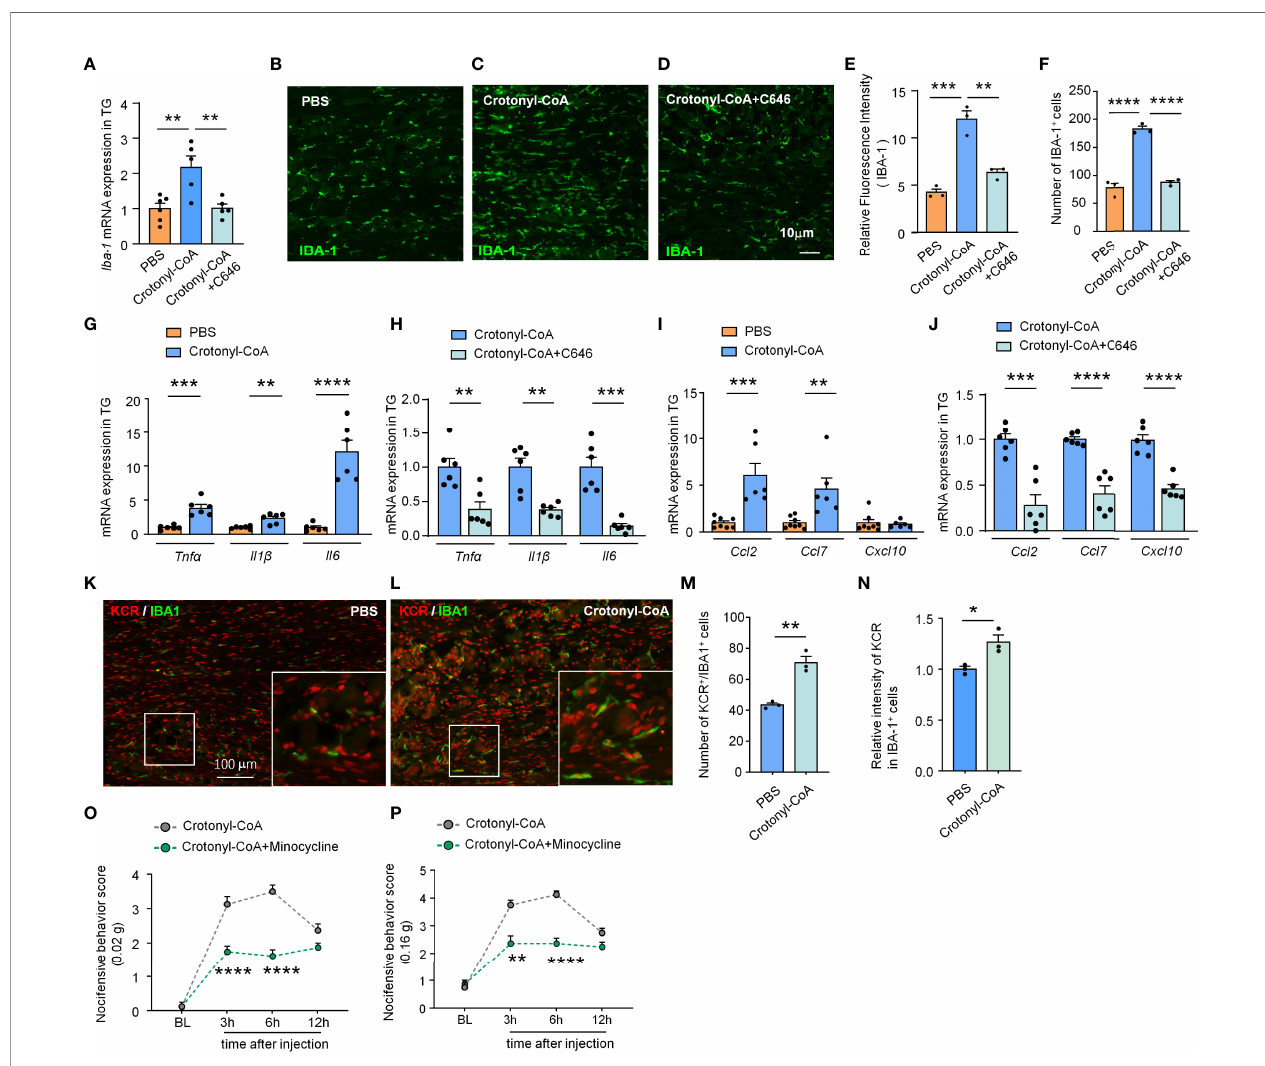
FIGURE 5 | C646 blocked crotonyl-CoA induced macrophage activation and the upregulation of in fl ammatory factors and chemokine in TG. (A) C646 suppressed the upregulation of Iba1 mRNA induced by Crotonyl-CoA Lithium in TG. ** P <0.01, n = 5-6, One-way ANOVA followed by Bonferroni ’ s test. (B – F) Representative images and Quantitative analysis of immuno fl uorescence staining showing C646 (1 m g) signi fi cantly decreased Crotonyl-CoA Lithium induced IBA-1 upregulation (E) and the number of IBA-1 positive cells (F) in TG. ** P <0.01, *** P <0.001, **** P <0.001, One-way ANOVA followed by Bonferroni ’ s test, n = 3 mice per group, 3 sections per mouse. (G) The mRNA levels of Tnf a , Il1 b and Il6 increased signi fi cantly after Crotonyl-CoA Lithium treatment, ** P <0.01, *** P <0.001, **** P <0.001, n = 6, student ’ s t-test. (H) C646 signi fi cantly decreased the mRNA expression of Tnf a , Il1 b and Il6 upregulated by Crotonyl-CoA Lithium, ** P <0.01, *** P <0.001, compared with the Crotonyl-CoA Lithium group, n = 6, student ’ s t-test. (I) Crotonyl-CoA Lithium signi fi cantly increased the mRNA level of Ccl2 and Ccl7 , ** P <0.01, *** P <0.001, compared with the PBS group, n = 6-8, student ’ s t-test. (J) C646 signi fi cantly decreased the mRNA expression of Ccl2 , Ccl7 and Cxcl10 , *** P <0.001, **** P <0.0001, compared to Crotonyl-CoA Lithium, n = 6, student ’ s t-test. (K – N) Representative images (K, L) and statistics of the number of KCR and IBA-1 double-positive cells (M) and the fl uorescence intensity of KCR in IBA-1 positive cells (N) 6 hours after intra-TG injection of PBS or Crotonyl-CoA Lithium on naïve mice. * P <0.05, ** P <0.01, N = 3 mice per group, 3 sections per mice, student ’ s t-test. (O, P) Minocycline (1 nmol per mouse) signi fi cantly attenuated Crotonyl-CoA-induced mechanical allodynia when minocycline and Crotonyl-CoA Lithium were injected simultaneously, ** P <0.01, **** P < 0.0001 compared with the Crotonyl-CoA Lithium group, n=8 in each group, Two-way RM ANOVA followed by Bonferroni ’ s